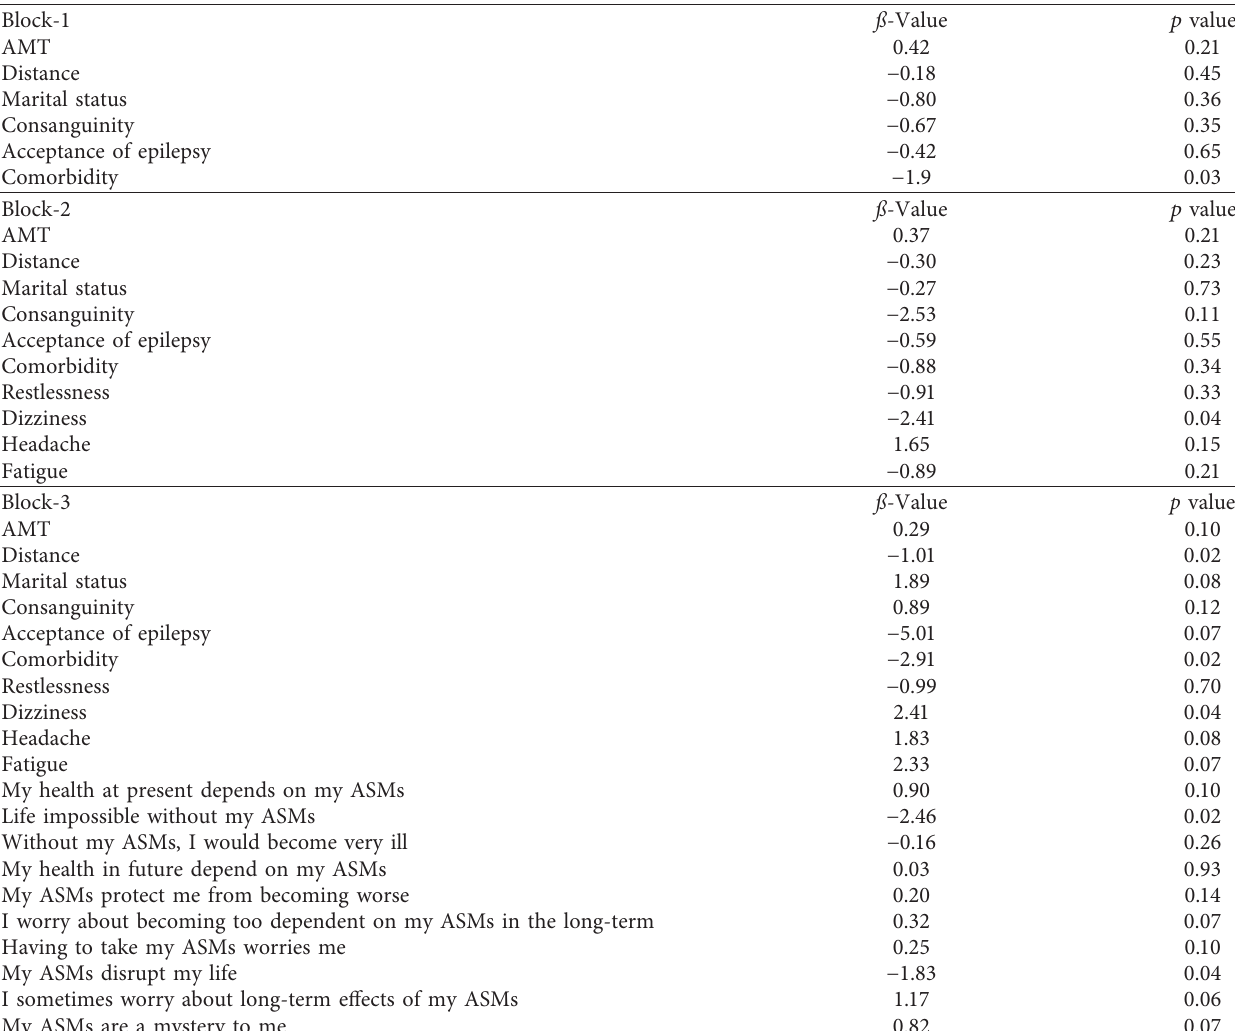
Table 3: Hierarchical regression related to epilepsy among participants assessed for medication beliefs and adherence to antiseizure